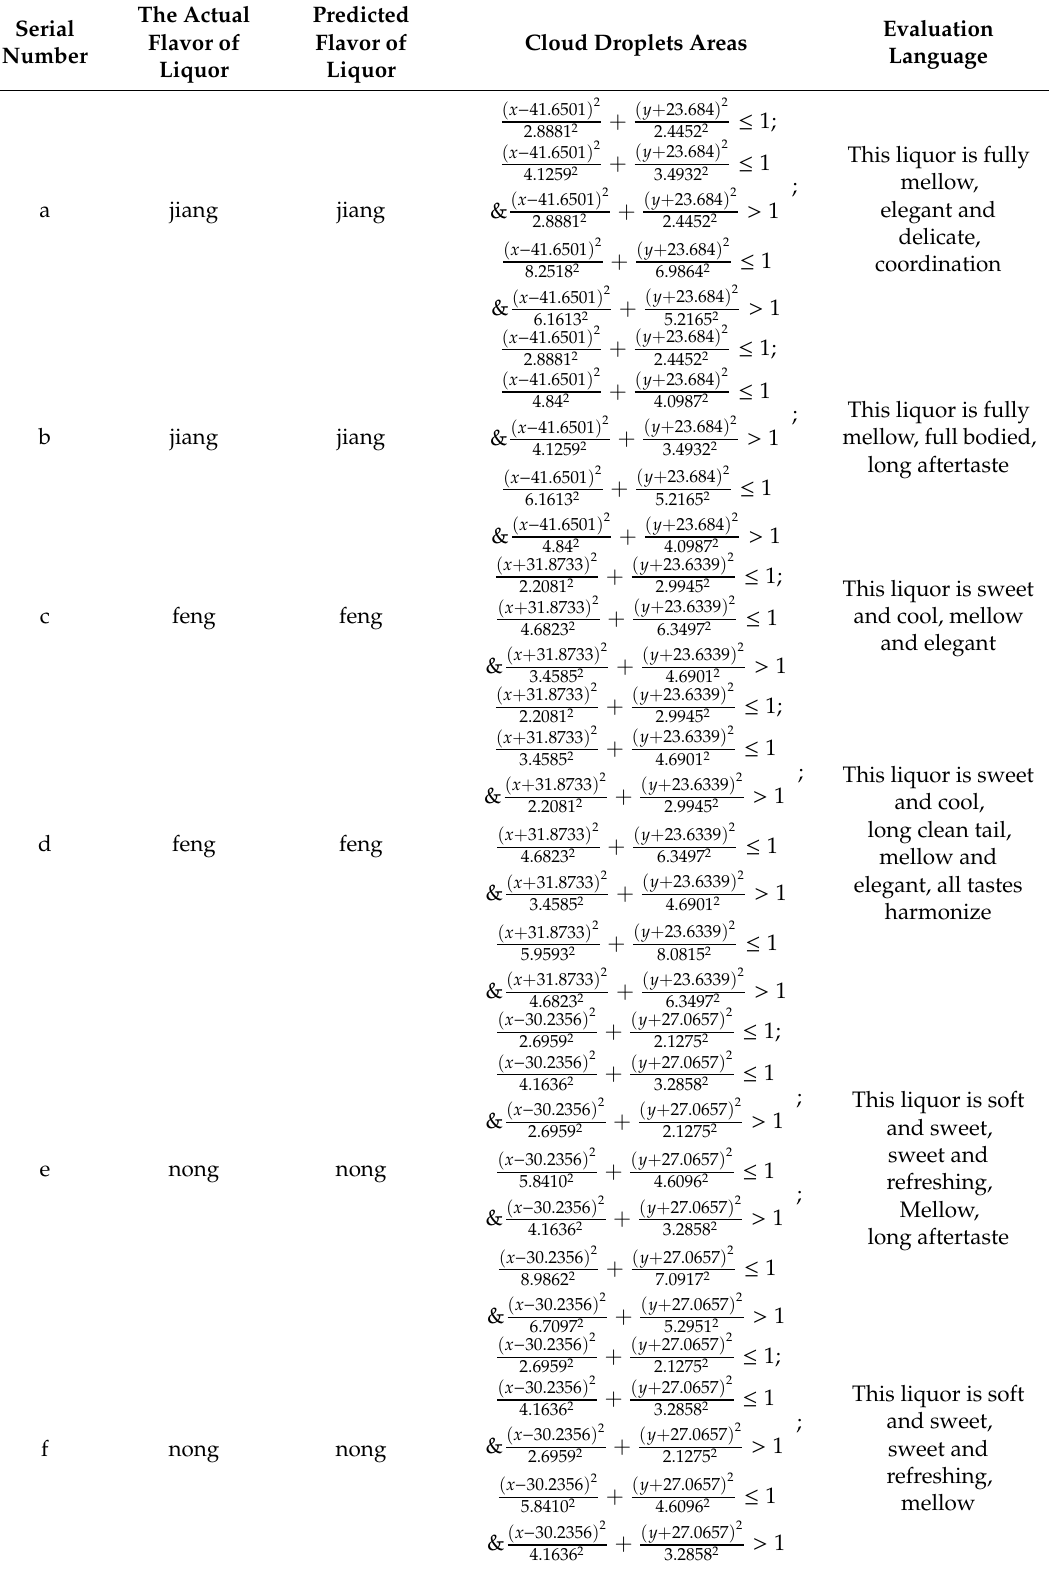
Table 4. Results of 8 groups of liquor experimental